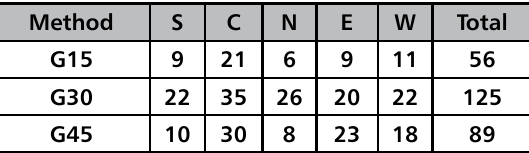
Number of those 1 x 1 m quadrats in which both sessile oak and hornbeam occurred in the fourth year of the regeneration (2008). Abbreviations are given at Table 1 and